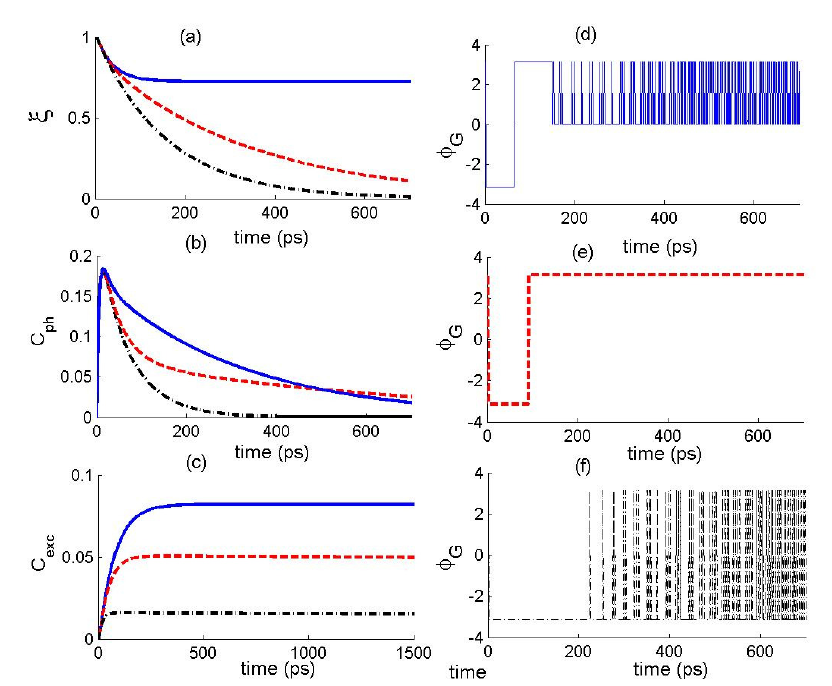
Figure 3. The temporal behavior of ( a ) state fidelity ξ ( t ) , ( b ) photons-state coherence C ph ( t ) , ( c ) exciton-state coherence C exc ( t ) and ( d – f ) the total phase φ G of the photon–exciton state for α = 10 − 8 , ( g , κ ) = ( 0.05,0.2 ) , ε = 0.01 κ , where γ = 0 (solid curve), γ = 0.01 (dashed curve), and γ = 0.1 (dash-dotted